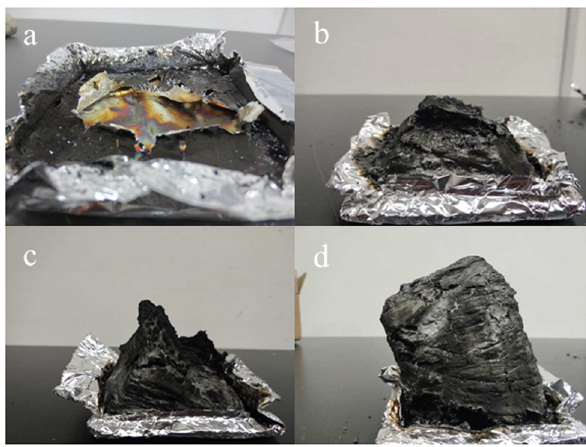
Figure 8: Digital photographs of the char residues of fl ame retarded EP after the cone calorimetric test ( a: EP, b: EP1, c: EP2, and d: EP3 ) .